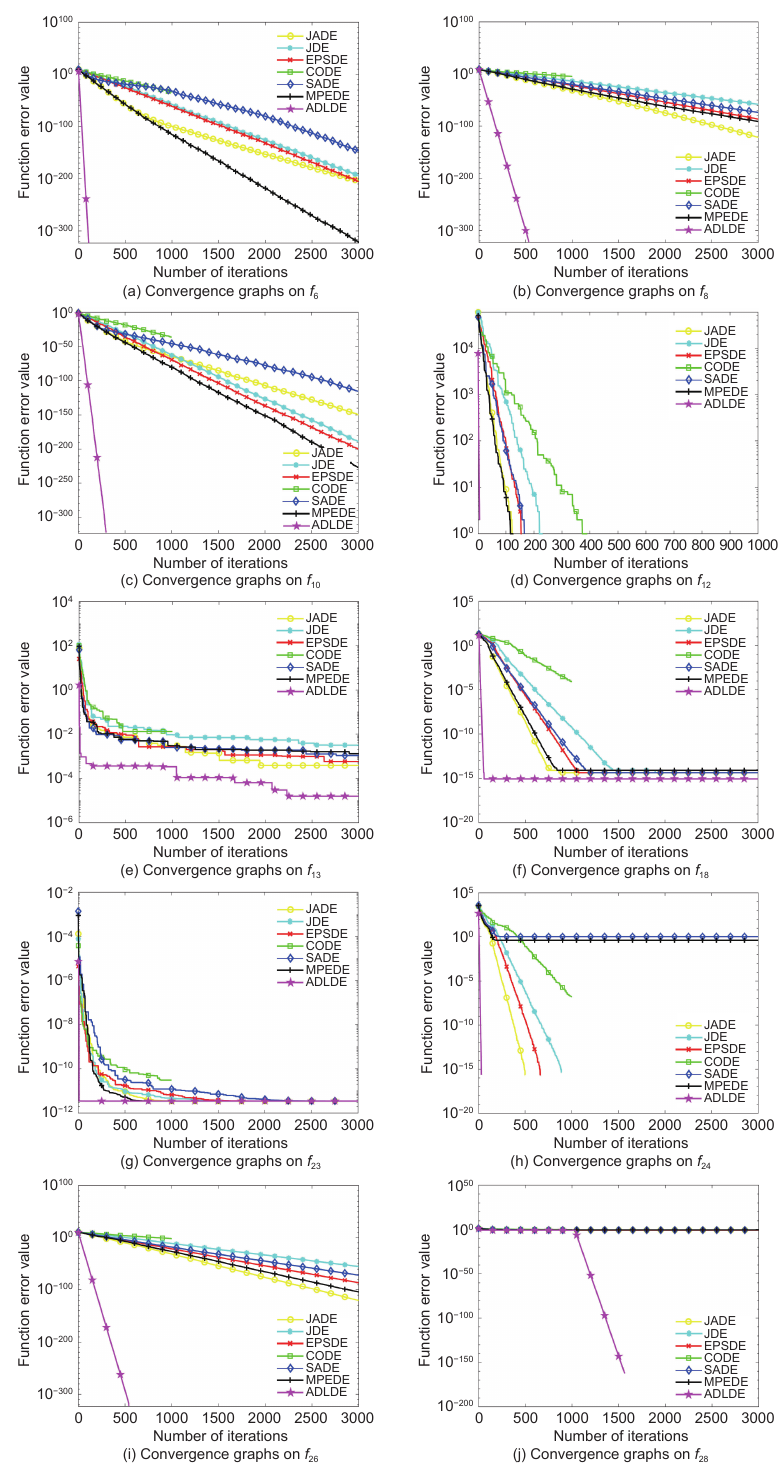
Fig. 2 Convergence curves on ten representative benchmark functions when D =